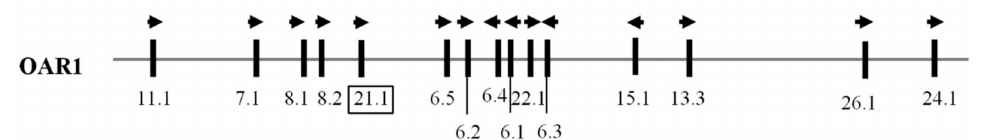
Figure 3. Location of KRTAP21-1 and other KRTAPs on ovine chromosome 1. The newly identified ovine KRTAP21-1 is shown in a box, along with the fourteen previously identified KRTAPs . The vertical bars represent the location of the different KRTAPs and the arrowheads indicate the direction of their transcription. The numbers below the bars indicate the name of the respective KAP genes (i.e., 24.1 is KRTAP24-1